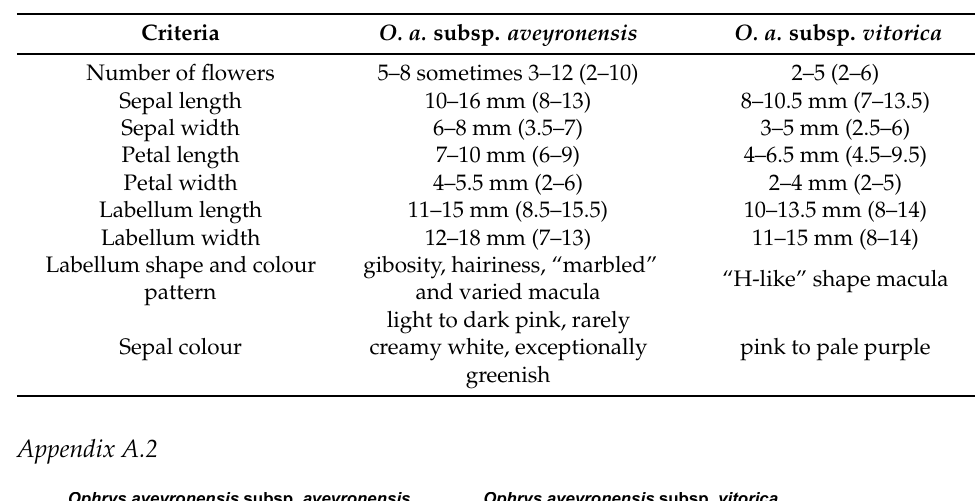
Table A2. Summary table of identification criteria for O. aveyronensis subspecies from flora [39]. For comparisons, min and max of our measures are given in brackets.